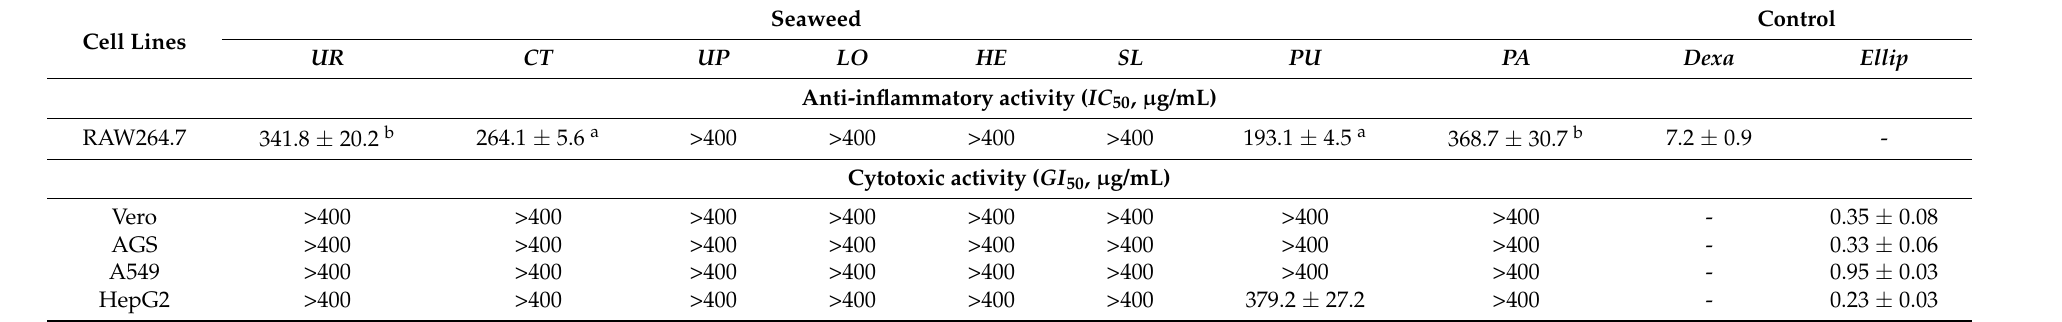
Table 6. Anti-inflammatory and cytotoxic activity of algal